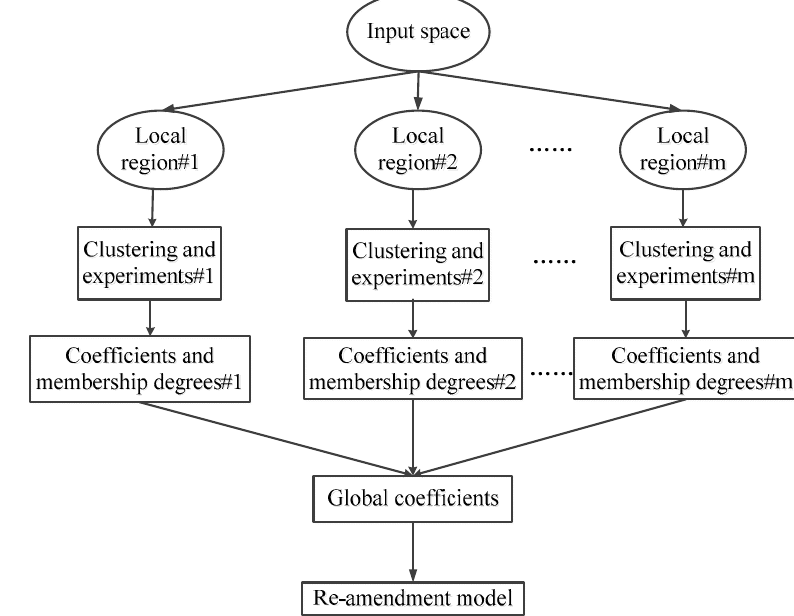
Figure 1. Local migration principle diagram.